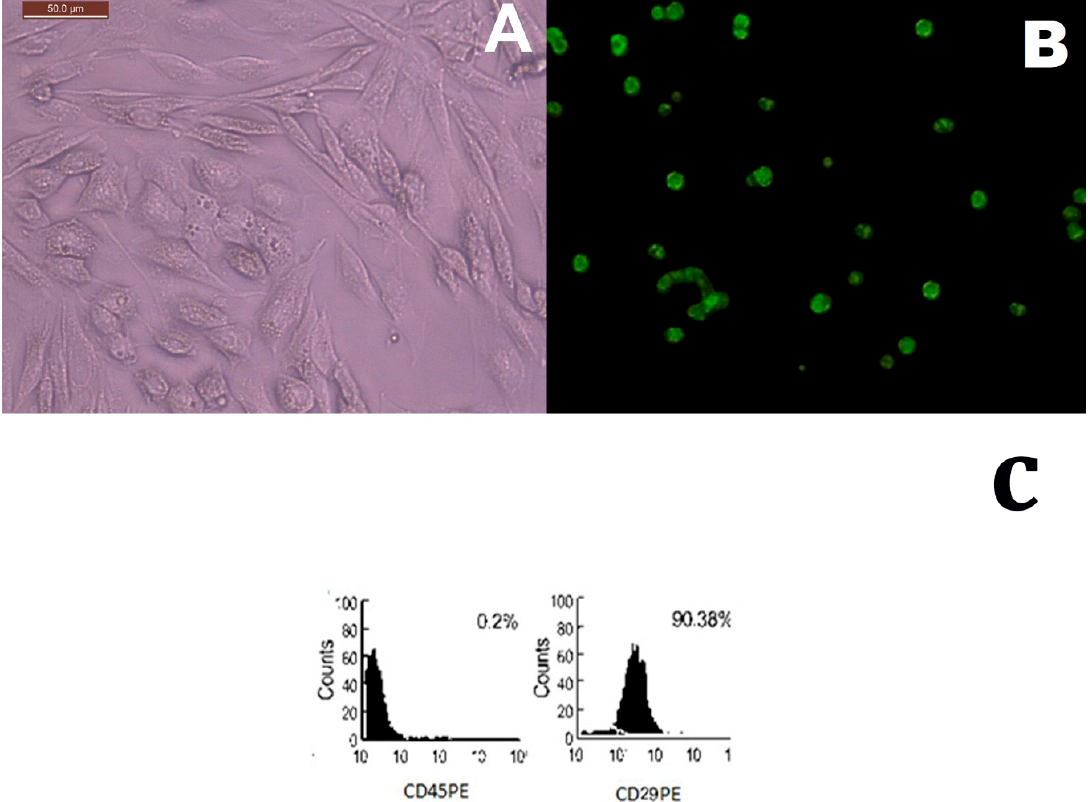
Figure 1. ( A ) An inverted microscope micrograph on day 14 from primary culture of mesenchymal stem cells showing many spindle-shaped stem cells, × 200. ( B ) Fluorescent microscopic image of tissue culture demonstrating the green fluorescence of MSCs labeled with GFP two weeks after implantation (fluorescent technique, × 200). ( C ) Flow cytometric analysis of surface antigens of MSCs, MSCs were positive for CD29 and negative for CD45.